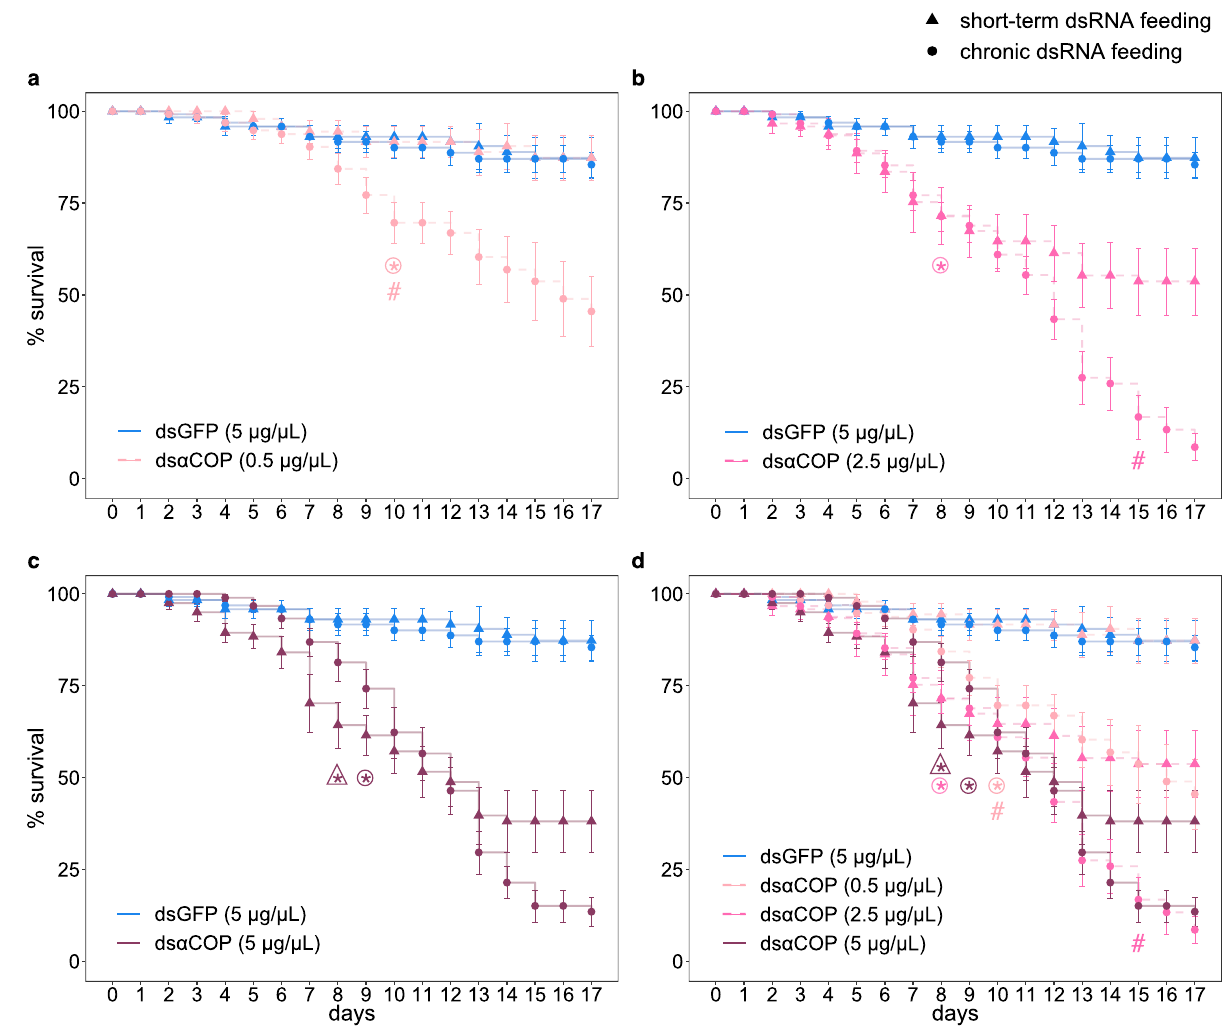
Fig. 1 Survival (%) of Brassicogethes aeneus in each treatment in the RNAi assay, totalled over all three experimental replicates (starting n = 15 biologically independent cages of insects per treatment). Survival curves show B. aeneus survival rates for short-term (3 days) and chronic (17 days) exposure to dsRNA treatments: ds α COP at 0.5 μ g/ μ L ( a ); ds α COP at 2.5 μ g/ μ L ( b ); ds α COP at 5 μ g/ μ L ( c ); and all ds α COP treatments shown together ( d ). Asterisk ( * ) indicates signi fi cant difference ( p < 0.05) in survival, compared to dsGFP 5 µ g/ µ L (control) treatment. Colour of the asterisk indicates the corresponding dsRNA and concentration. Asterisk in a triangle indicates that the signi fi cance corresponds to short-term dsRNA feeding. Asterisk in a circle indicates that the signi fi cance corresponds to chronic dsRNA feeding. Hash symbol (#) indicates a signi fi cant difference ( p < 0.05) in survival between short-term and chronic dsRNA feeding groups. Colour of hash symbol indicates the corresponding dsRNA and concentration. Asterisks and hash symbols are only used where values become and remain signi fi cant. Analysed using Kruskal – Wallis test, followed by Wilcoxon ’ s rank-sum test with Bonferroni correction. Error bars: